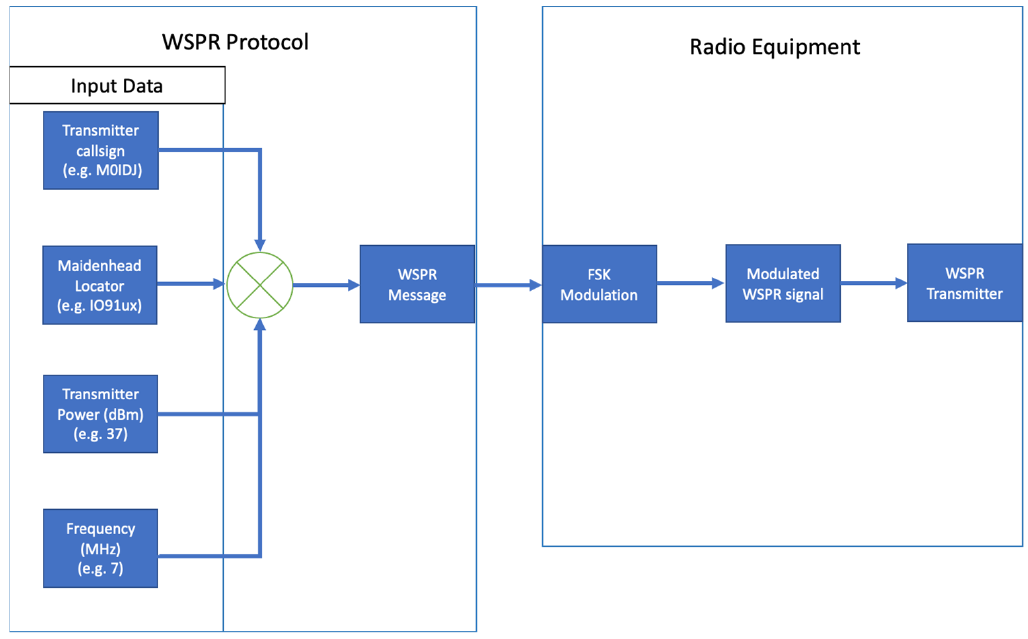
Figure 2. WSPR signal transmission example block diagram.